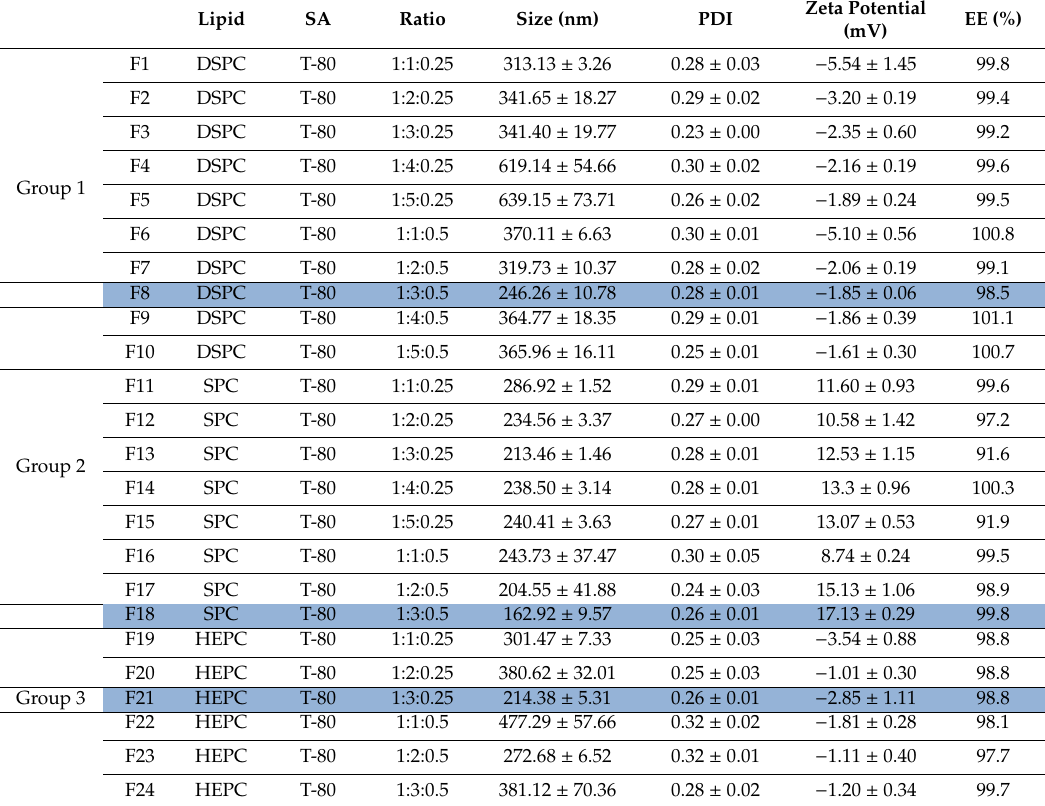
Table 1. Physical characteristics of carvedilol-loaded